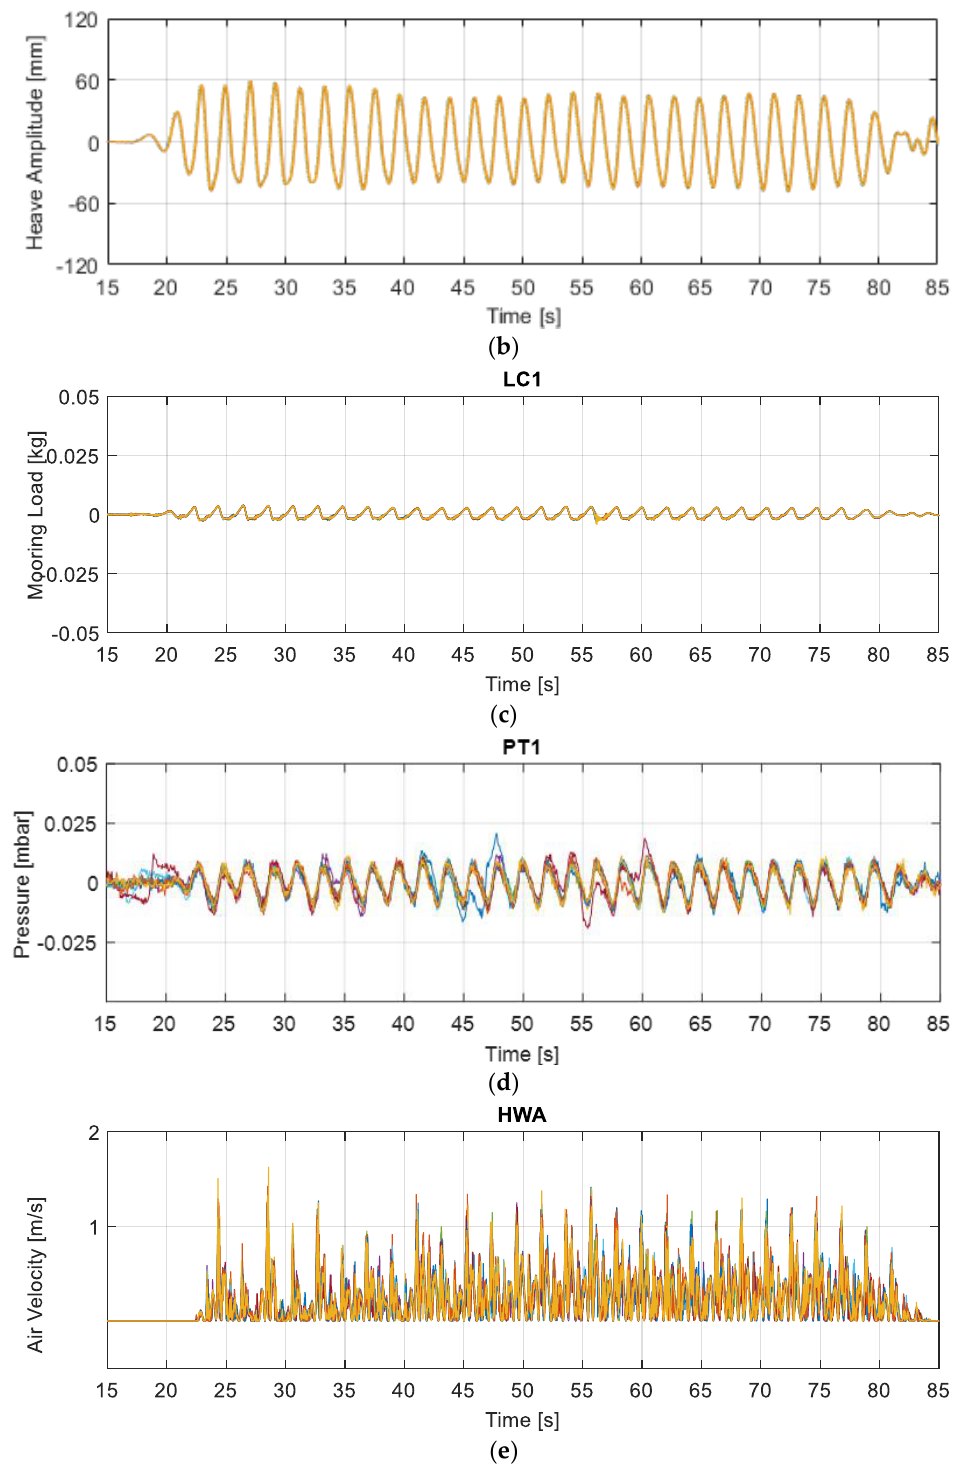
Figure 14. Testing the repeatability of the measurements under the identical conditions (H14: d = 0.625 m, H = 0.1 m, and T = 2.1 s), the tests were repeated ten times. ( a ) surge, ( b ) heave, ( c ) mooring load, ( d ) air velocity, and ( e ) pressure.